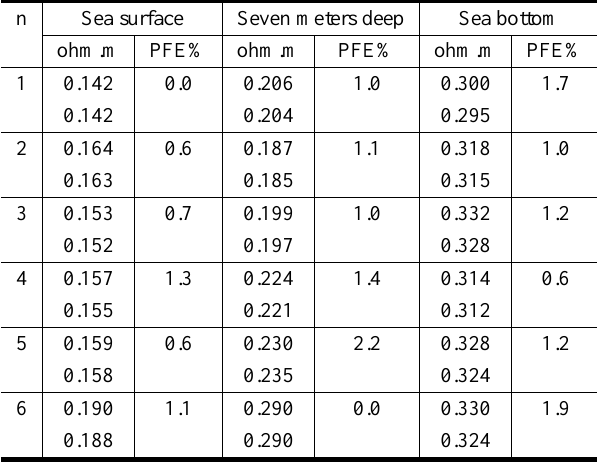
Percent frequency effect (PFE) employing 1.0 Hz and 8.0 Hz and the vertical bar electrode (L = 0.03 m) for the given spreads n and